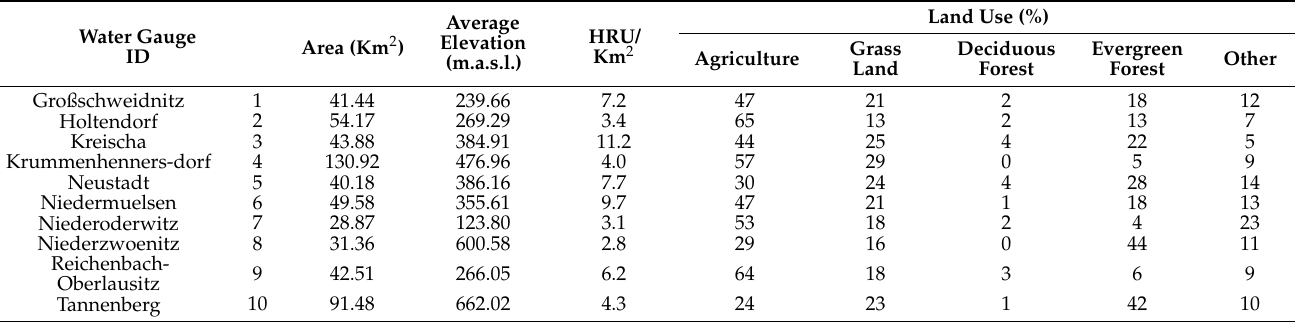
Figure 1. An overview of the study region, Saxony, Germany (WGS-84 Pseudo-Mercator projection), with a background of a digital elevation model (DEM) based on SRTM30. Presented are also radar stations of DWD, recording meteorological station from OSW and the ten selected catchments. The ID numbers of the catchments here match those in Table 1. Table 1. Summary of the important characteristics of selected catchments.